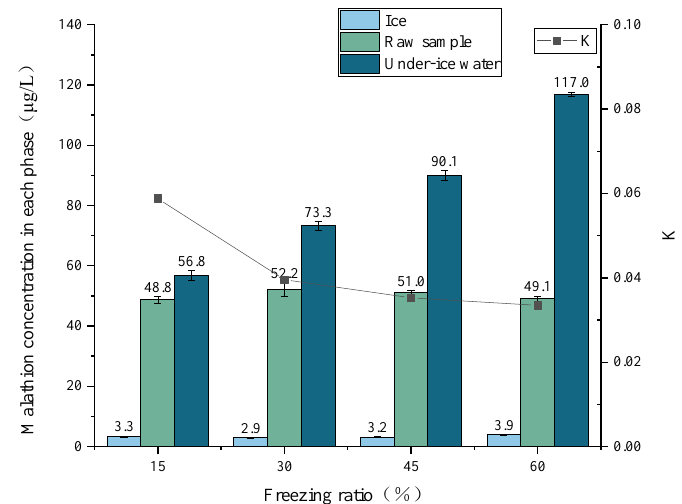
Figure 4. Migration rule of the malathion at different freezing ratios.